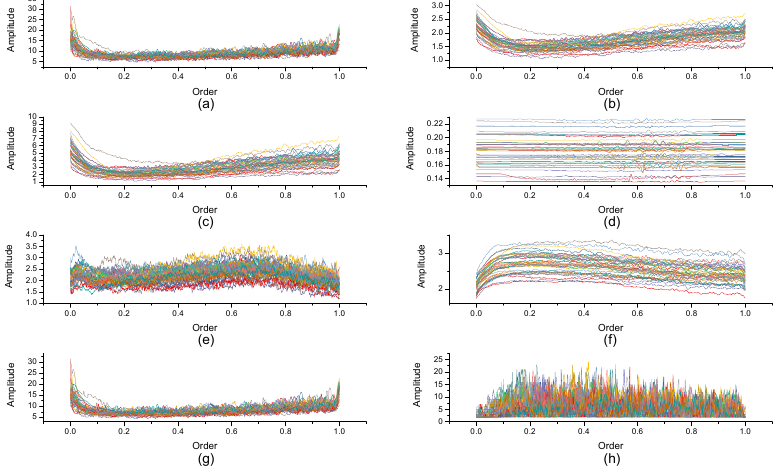
Figure 8. The Order–Amplitude figures of different features of 40 groups for the dwstairs action. ( a ) range , ( b ) std , ( c ) var , ( d ) rms , ( e ) IQR , ( f ) mean , ( g ) pksMean and ( h ) pksNum . Micromachines 2019 , 10 , x FOR PEER REVIEW